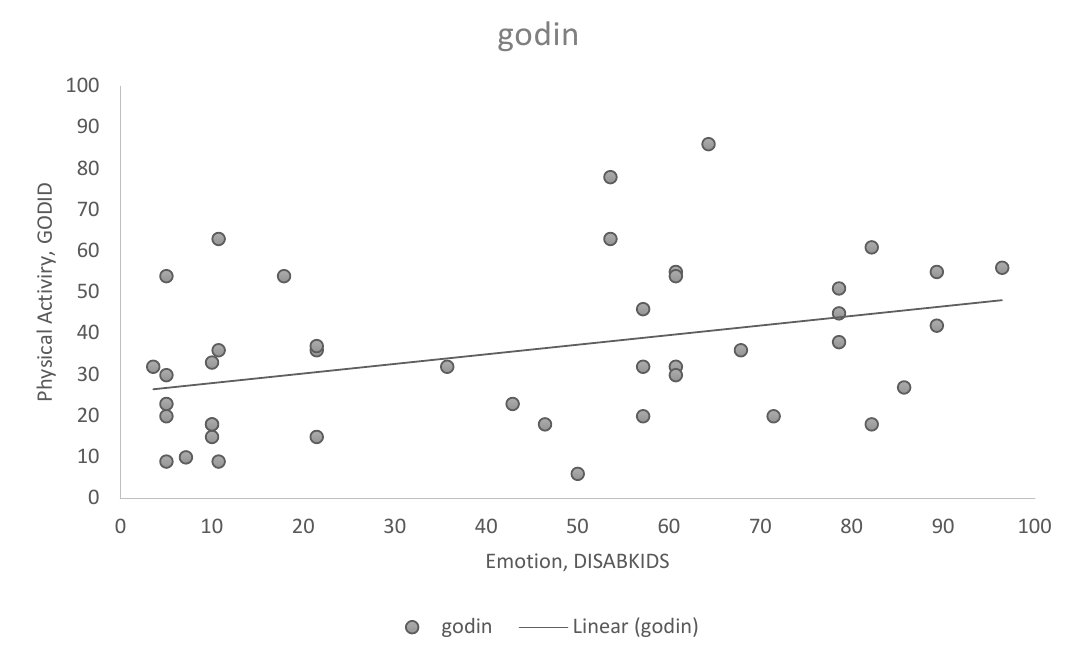
Figure 4. Patients with a greater degree of physical activity showed a better overall quality of life (r: 0.372; p : 0.014). No significant correlation was found between PA and lung function parameters, FEV1pp, and LCI among pwCF ( p = 0.572 and p = 0.271, respectively).